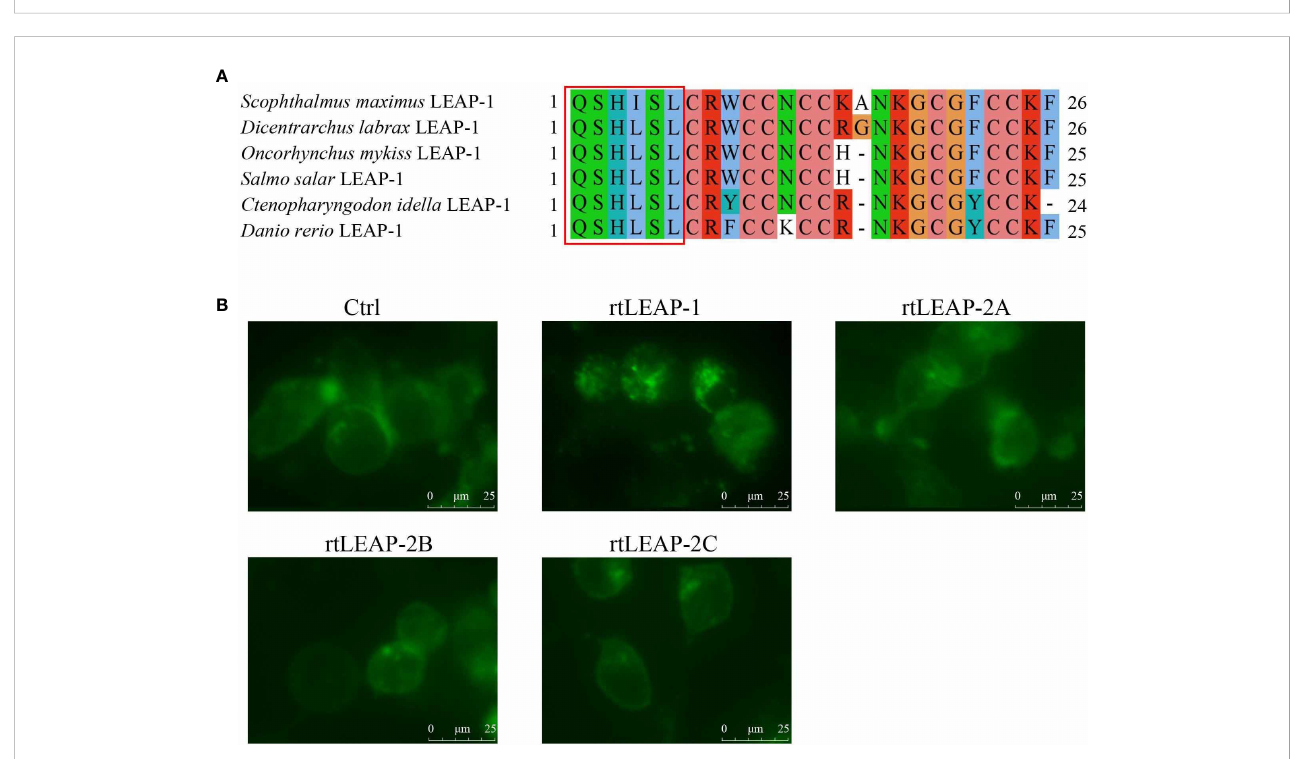
FIGURE 7 The effects of LEAPs on Fpn internalization. (A) Amino acid sequence alignment of LEAP-1 mature peptides in rainbow trout, grass carp, zebra fi sh, European sea bass, Atlantic salmon, and turbot. The Q-S/I-H-L/I-S/A-L motif at the N-terminus of the mature peptides are indicated with a red rectangle. GenBank accession numbers of the selected sequences are listed in Table 1. (B) The ability of LEAPs to internalize Fpn. HEK293T cells were seeded in 6-well plates and transfected with pEGFP-Fpn. After 24 h, cycloheximide (75 ug/mL) was added for 3 h, and then cells were incubated with rtLEAPs (1 m M) and PBS (blank control [Ctrl]) for 24 h. The images of cells were captured using a live cell